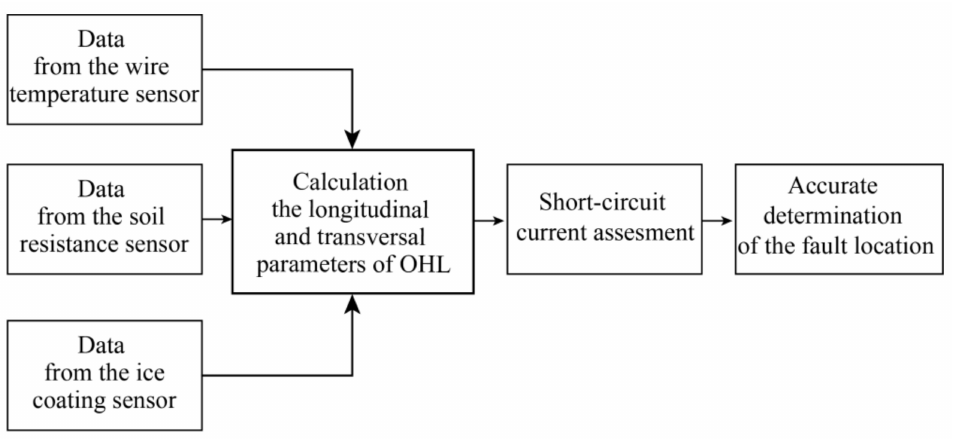
Figure 20. Algorithm for the refined determination of the damage location on overhead lines. To detect the fault, data on the external parameters of the environment are used, obtained from sensors installed on the overhead line. Reference values are not used, since it does not show the real picture of what is happening on the overhead line. As a result, the accuracy of fault detection on the overhead line is significantly